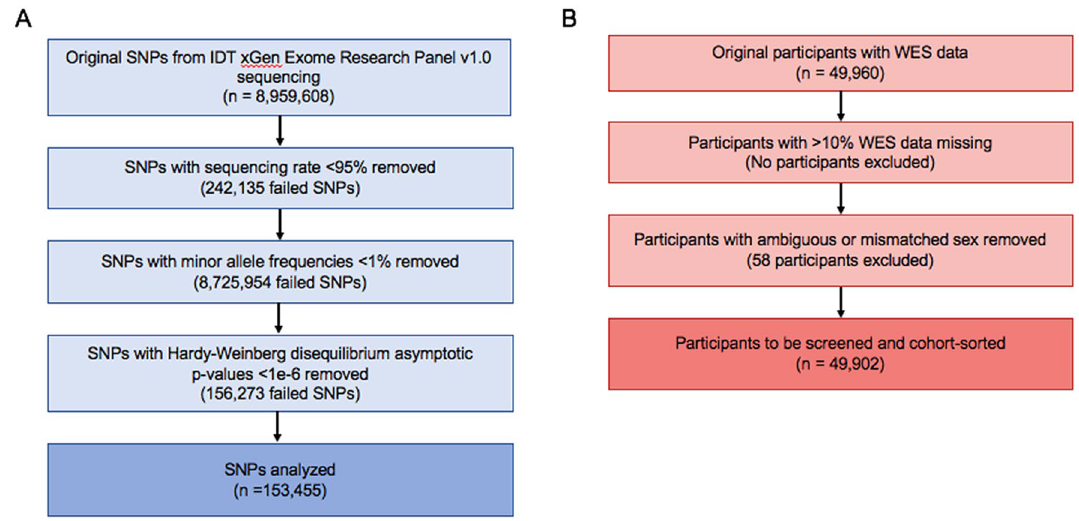
Figure 1. Workflow of quality control measures. Quality control measures directly applied to whole exome sequencing at the SNP ( A ) and participant level ( B